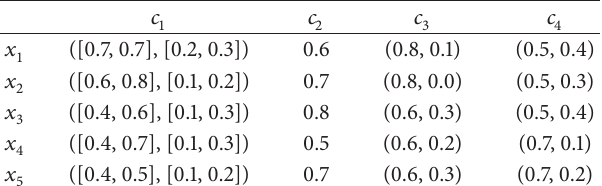
Table 2: Evaluation information at 𝑡 2 time episode.